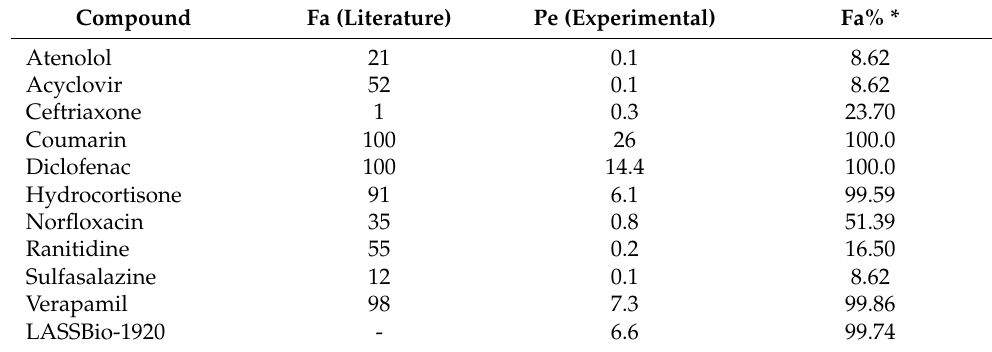
Table 8. Permeability coefficient (Pe *) of LASSBio-1920 and controls obtained by PAMPA-BBB tech- nique.